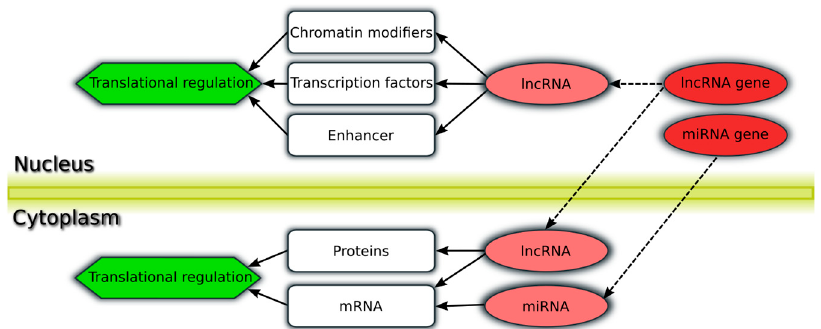
Figure 1. Schematic overview of miRNA and lncRNA regulation. miRNAs are transcribed as miRNA gene (light red circle) in the nucleus and further transported (dashed arrows) in the cytoplasm (darker red circle) where they regulate (continuous arrows) translation (green hexagon) through complementary mRNA binding (white rectangle). lncRNAs are transcribed in the nucleus (light red circle) and not only transported (dashed arrows) in the cytoplasm (darker red circle) and influence translation, e.g., through mRNA and protein binding (white rectangles), but can also regulate transcription (green hexagon), e.g., through chromatin modifier binding (white rectangles) in the nucleus. Table 1. Table summarizing the different lung cancer miRNA